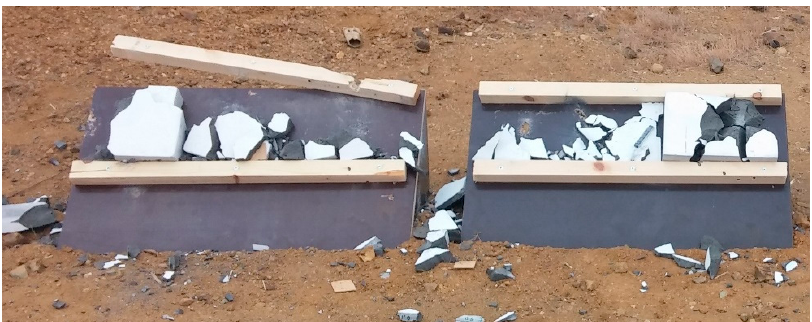
Figure 11. Slabs from mixture 0/16/6 (ultra-high performance concrete, UHPC) and high strength concrete (HSC) after projectile impact test.